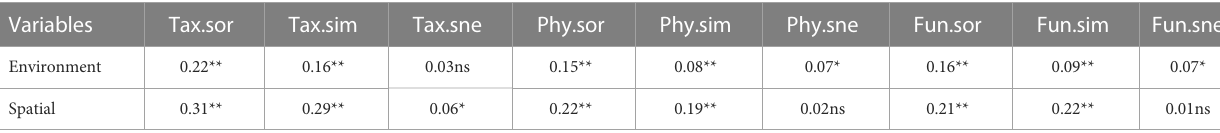
Tax.sor, Tax.sim, and Tax.sne represent taxonomic beta diversity, turnover, and nestedness, respectively. Phy.sor, Phy.sim, and Phy.sne represent phylogenetic beta diversity, turnover, and nestedness, respectively. Fun.sor, Fun.sim,and Fun.snerepresent functional betadiversity, turnover, andnestedness, respectively. The nsrepresents no signi fi cant difference(P >0.05), *P<0.05, **P<